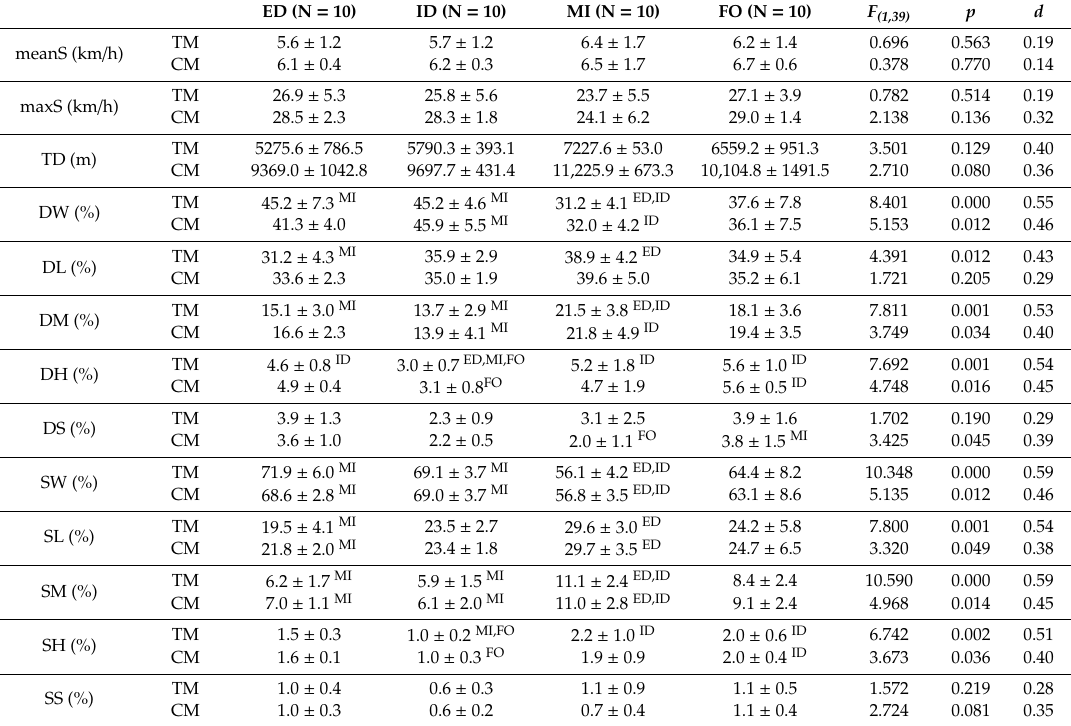
Table 4. One-way ANOVA of physical responses of soccer players in TM and CM according to playing